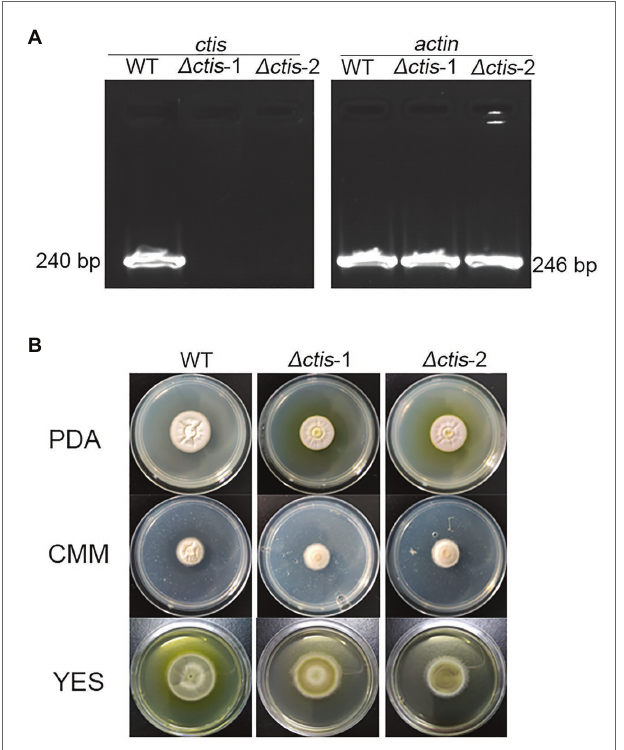
FIGURE 4 | High performance liquid chromatography (HPLC) analysis of secondary metabolite profiles of both Δ cits mutant and WT strains. Conidia of Δ cits and WT were inoculated in the rice medium and cultured at room temperate for 21 days, the secondary metabolites were extracted by using EtOAc, and then analyzed by HPLC.